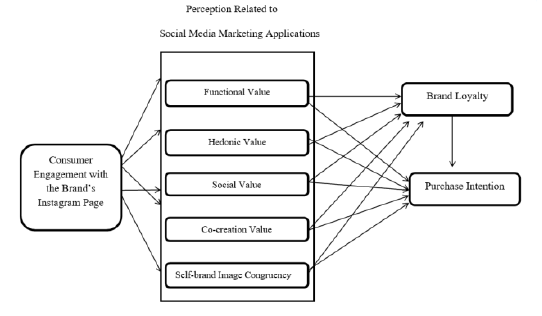
Figure 1. Proposed Conceptual